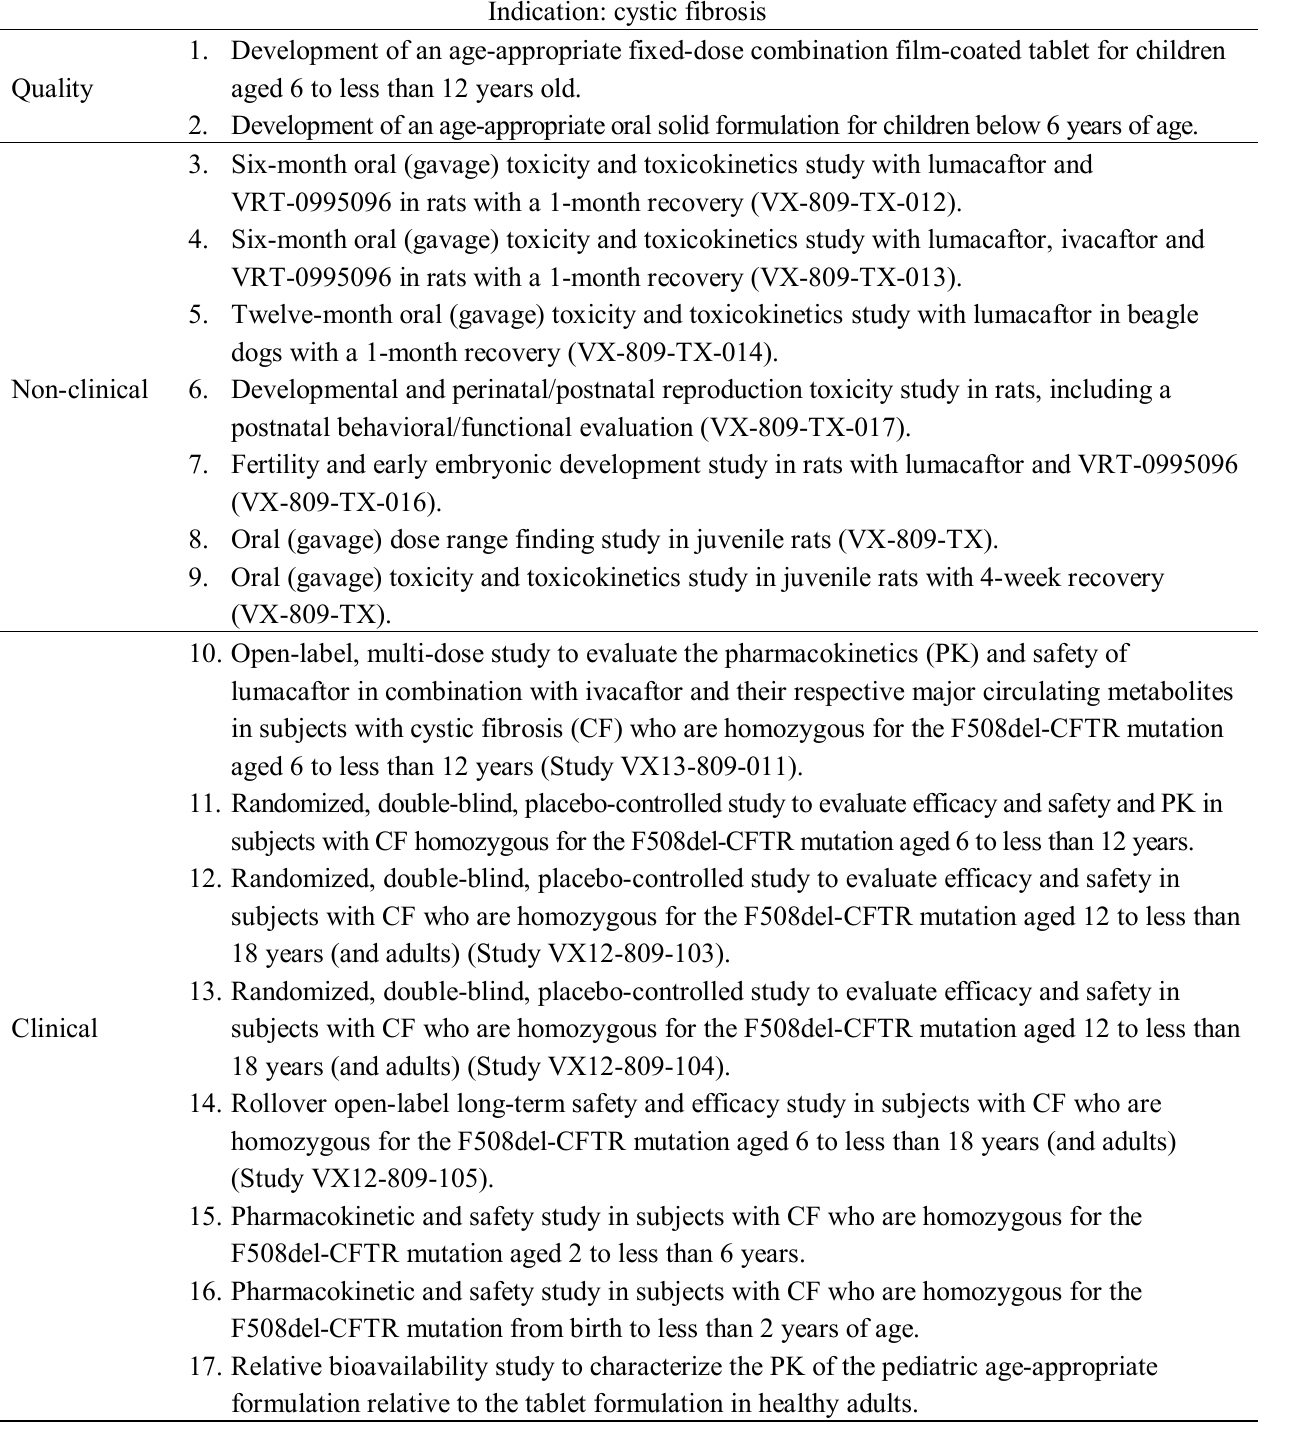
Table 6. PIP measures for